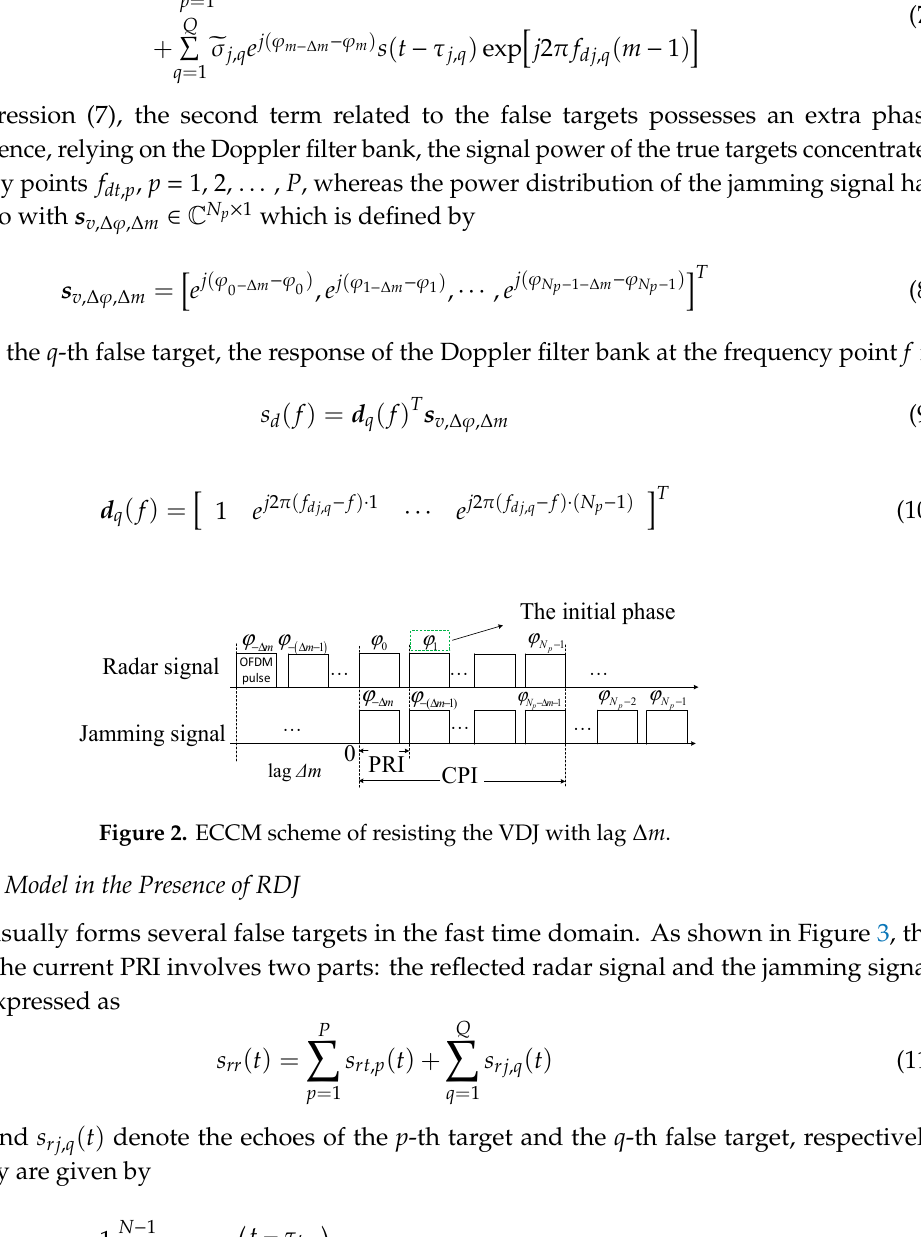
Figure 1. The mechanism of the deception jamming in a CPI with lag Δ m .